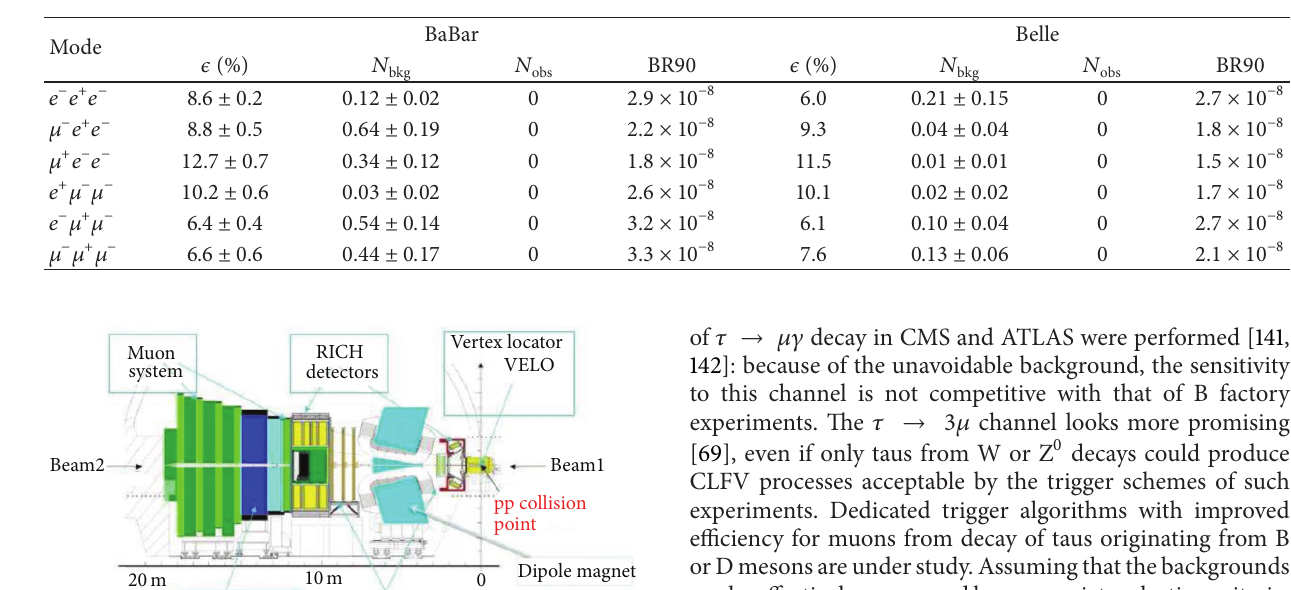
Table 5: Efficiencies, number of expected background and observed events and 90 % C.L. BR upper limits (BR90) for 𝜏 → 3ℓ CLFV searches for BaBar and Belle (adapted from [119, 120]).